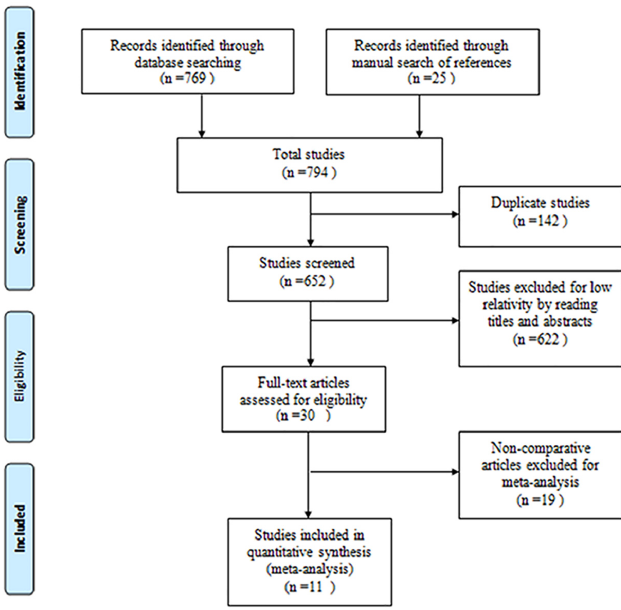
Fig 1. Flow diagram of the study selection process for the meta-analysis.